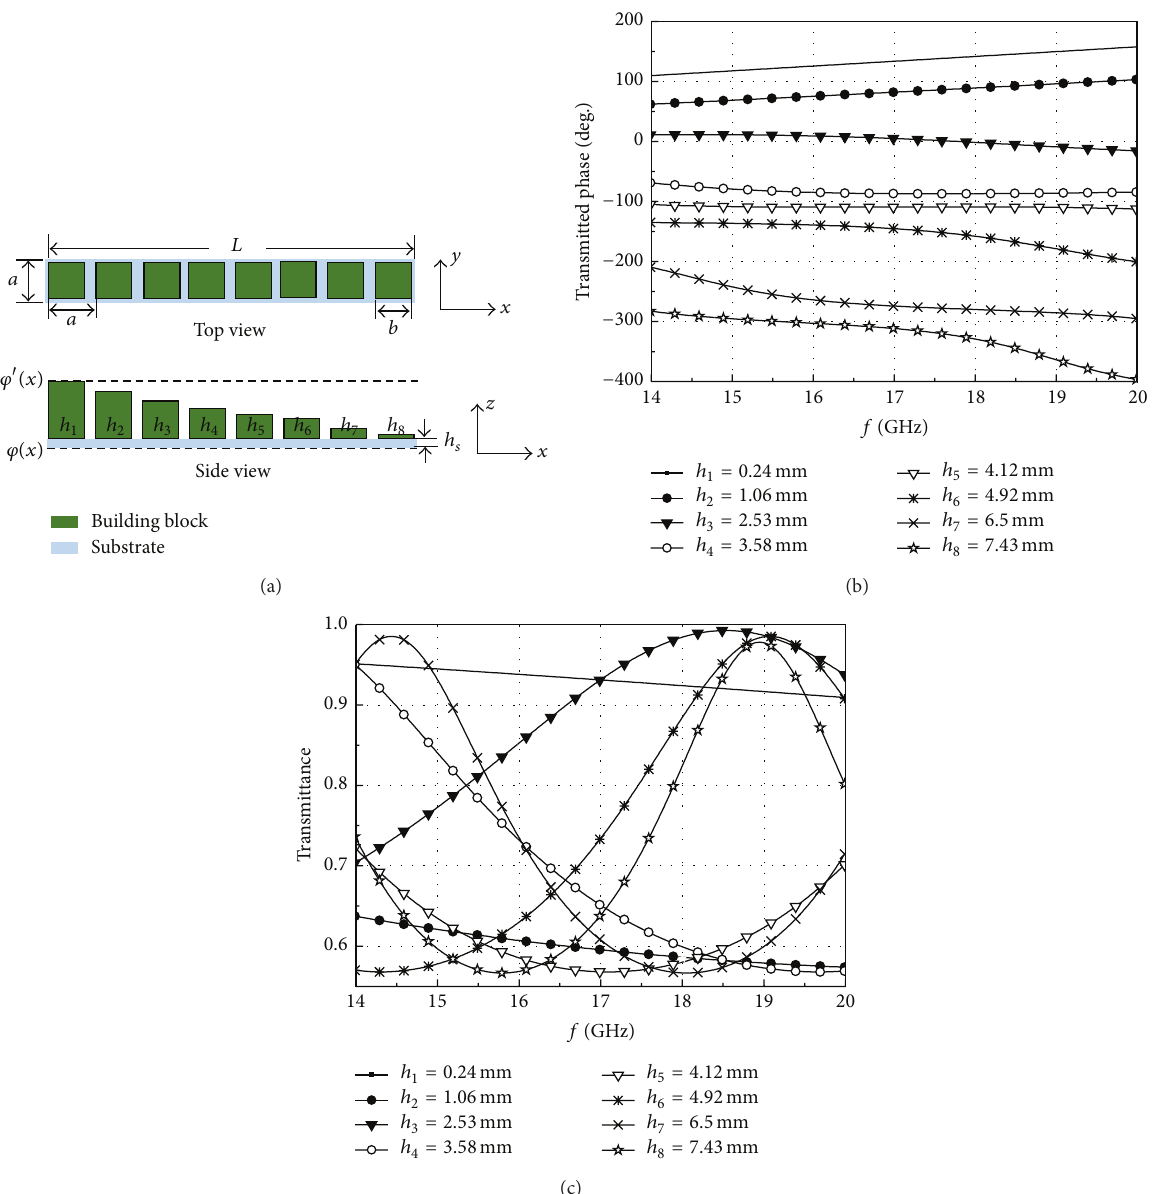
Figure 2: (a) Top and side view of the super unit cell of an electrically thin metasurface, which is composed of eight RO3210 dielectric building blocks and a RT5880LZ substrate. The detailed geometry of the super unit cell, in which 𝑎 = 6.25 mm, 𝑏 = 5.5 mm, ℎ 𝑠 = 0.76 mm, = 7.43 mm, ℎ = 6.50 mm, ℎ = 4.92 mm, ℎ = 4.12 mm, ℎ = 3.58 mm, ℎ = 2.53 mm, ℎ = 1.06 mm, and ℎ = 0.24 mm; (b) the ℎ 1 2 3 4 5 6 7 8 calculated frequency dependence of the transmitted phase shift, and (c) transmittance of each building